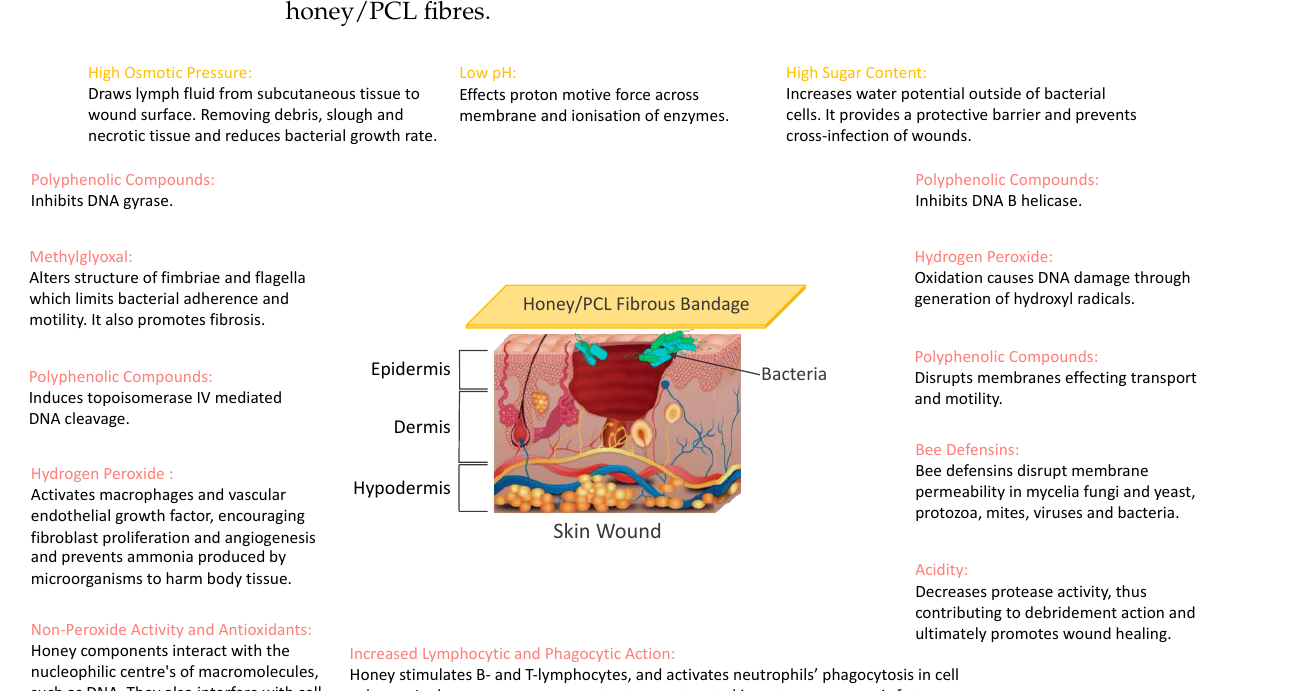
Figure 8. Antimicrobial mechanisms of Honey/PCL bandages during wound healing.